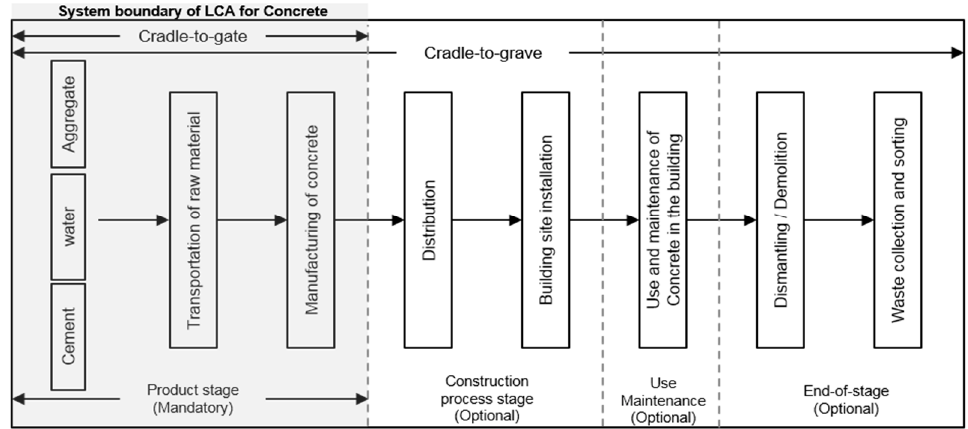
Figure 1. System boundary of LCA for Concrete.